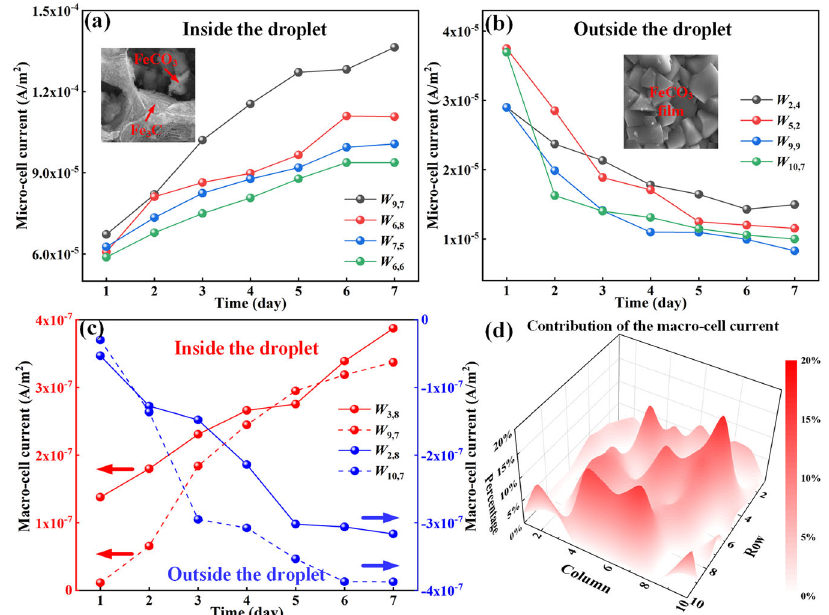
Fig. 11 The evolution of micro-cell currents and macro-cell currents. a Time dependence of the micro-cell current of typical wire electrodes beneath the droplet. b Time dependence of the micro-cell current of typical wire electrodes outside the droplet, c Time dependence of the macro-cell current of typical electrodes around the boundary of the droplet. d The contribution of the macro-cell current of the total corrosion loss of each wire